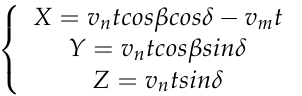
Figure 3. Working principle and components of spiral crop dividers.